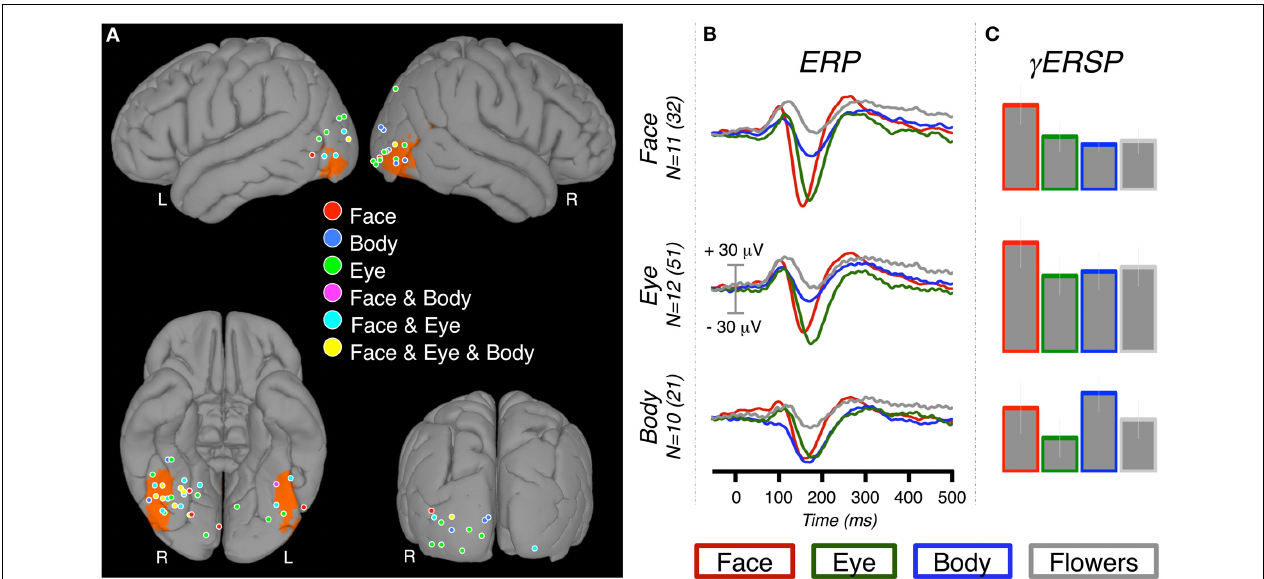
FIGURE 2 | ERP and γ ERSP response at category-selective sites. (A) The locations of 69 category-selective electrodes displayed on a standard brain (left panel). Selectivity was defined by contrasting each of the conditions of interest (faces, eyes, bodies) to flowers. Therefore, a single electrode could be identified as “selective” for more than one condition. The color at each location indicates which category (or categories) met selectivity criteria (see Materials and Methods). For reference to standard imaging results, the ORANGE overlay indicates voxels at which there is a ≥ 33% probability of being face-selective in a face vs. scene fMRI experiment (Engell and McCarthy, 2013). (B) The